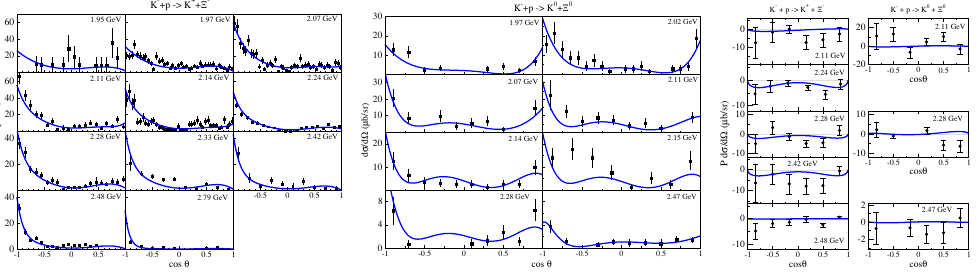
P for both the d Ω